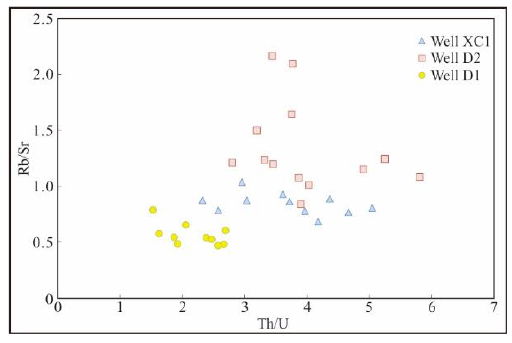
Figure 9. the plot of Rb/Sr to Th/U. Figure 9. The plot of Rb/Sr to